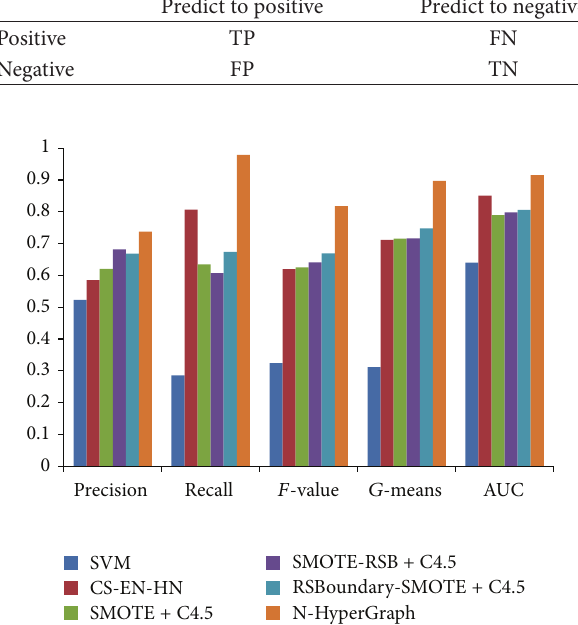
Figure 8: The average value of each